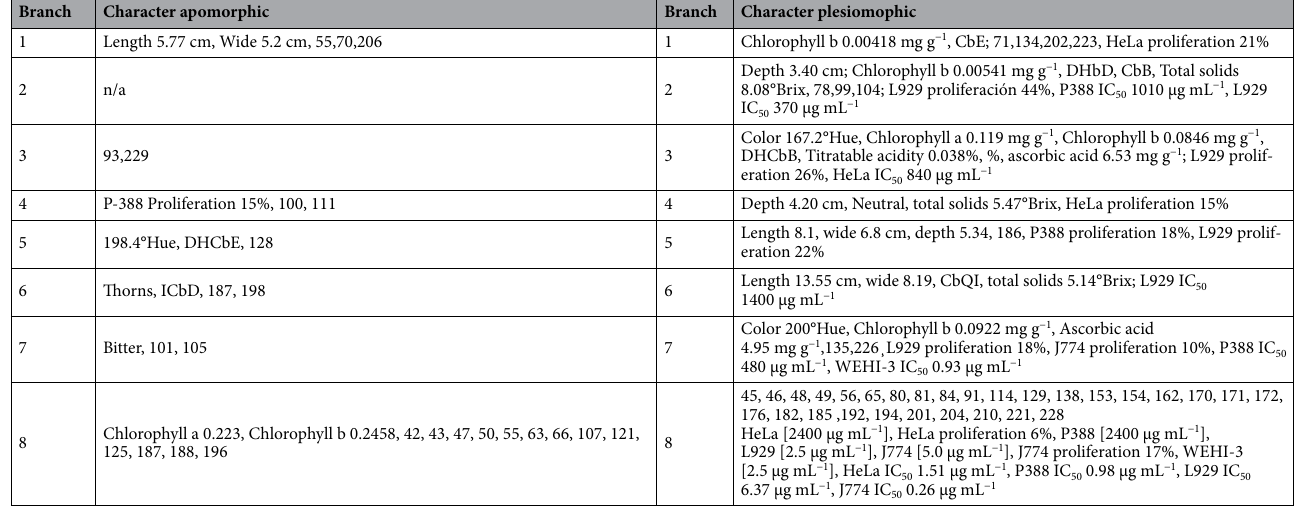
Table 2. Apomorphic and plesiomorphic characters identified in the branches of the heuristic clade based on morphological, biochemical, and genetic variables of ten Sechium spp. genotypes. The diagonal indicates the character and its relevant character